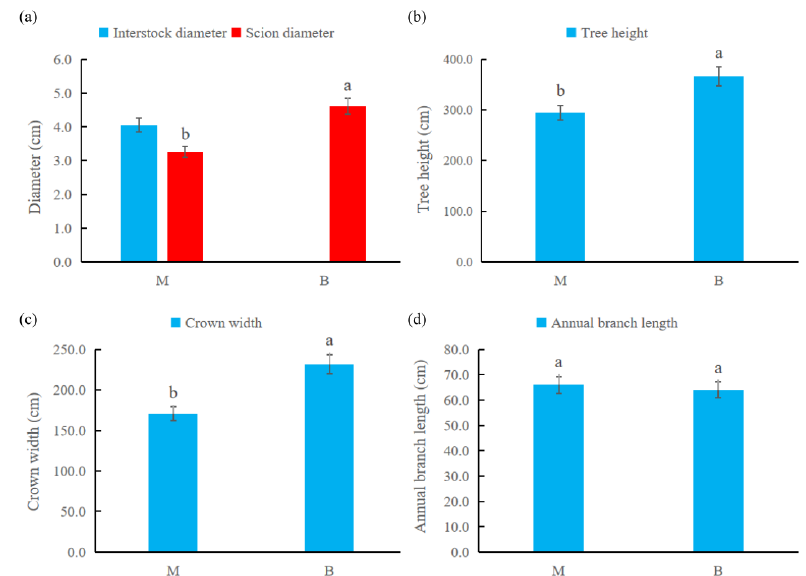
Figure 1. Effect of dwarf interstock on tree body growth indices. ( a ) Effect of dwarf interstock on diameter of apple tree. ( b ) Effect of dwarf interstock on height of apple tree, ( c ) Effect of dwarf interstock on grown width of apple tree. ( d ) Effect of dwarf interstock on annual branch length of apple tree. (Significant differences between values in the same row are indicated by different lowercase letter superscripts ( p < 0.05)).